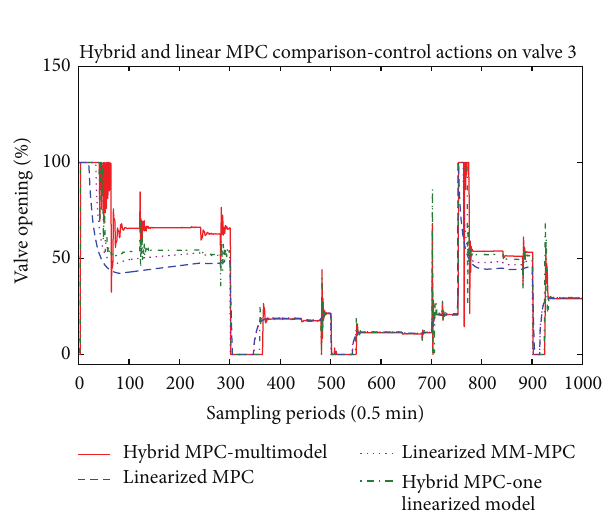
Figure 10: Control actions of the third valve.